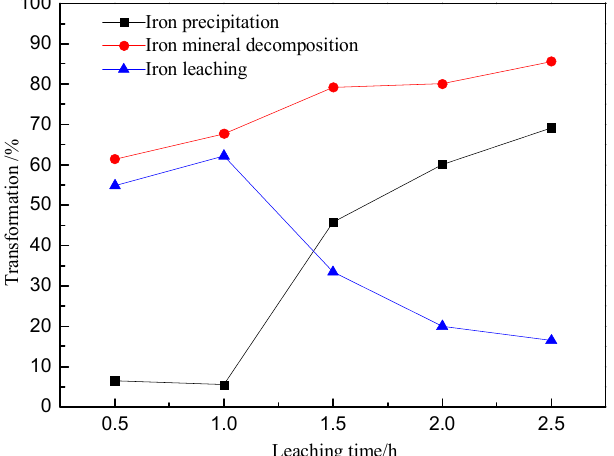
Figure 14. Relation between the extraction and extent of precipitation of iron as a function of the leaching time.